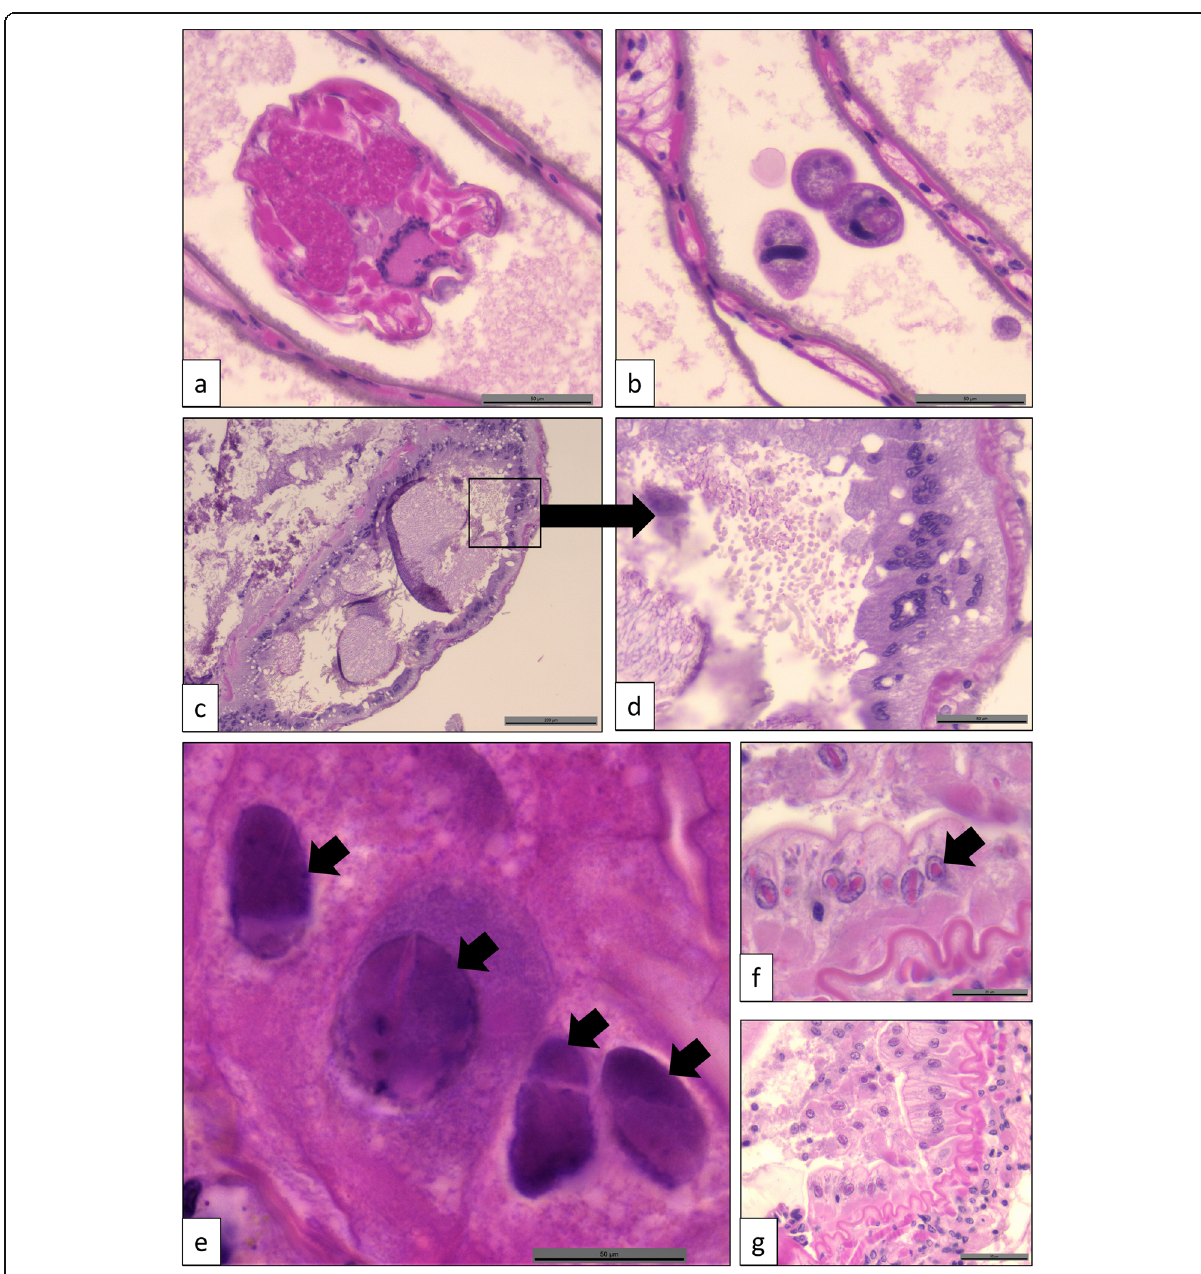
Fig. 1 Histopathology of Aratus pisonii collected from the Florida Keys. A A gill-based ectoparasite including a transverse section through the middle of the animal, likely Polychaeta. B Ciliated protozoa sitting between the gill lamellae. C-D A network of fungal hyphae in the male gonad. E Nudivirus-infected nuclei of hepatopancreatocytes. F-G Putative gut-infection consisting of virally infected gut-epithelial